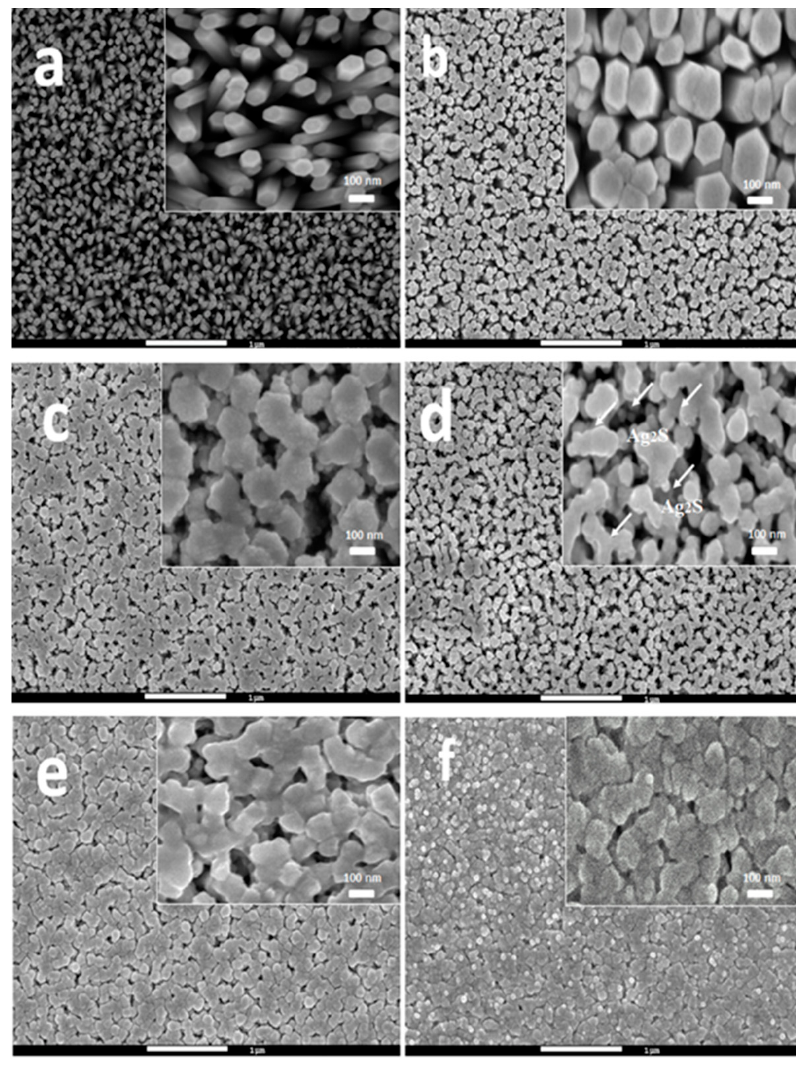
Figure 1. FESEM images of ZnO NRs ( a ); Ag 2 S/ZnO NRs/ITO with various concentrations of AgNO 3 ( b ) 0.001 M; ( c ) 0.003 M; ( d ) 0.005 M; ( e ) 0.008 M; and ( f ) 0.01 M. The figures' insets show the FESEM images at a higher